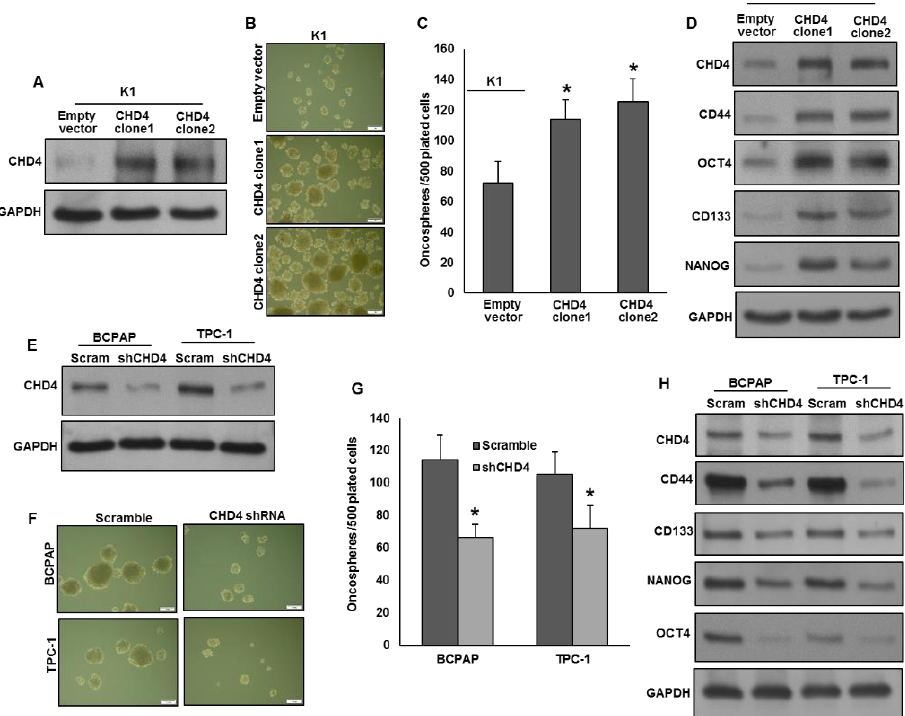
Figure 3. CHD4 promotes the self-renewal ability of spheroids generated from PTC cells. ( A ) Forced expression of CHD4 in low expressing cells. ( B , C ) Forced expression of CHD4 increases spheroid growth. K1 cells were transfected with either empty vector or CHD4 cDNA and cells were subjected to sphere forming assay. Spheroids in the entire dish were counted. (Scale bars, 1 mm). ( D ) Forced expression of CHD4 increases stemness of spheroids as confirmed by immunoblotting using stem cell markers. K1 cells were transfected with either empty vector or CHD4 cDNA and grown in sphere medium. Proteins were isolated from spheroids and immunoblotted with antibodies against CHD4, CD44, OCT4, CD133, NANOG and GAPDH. ( E ) Knockdown of CHD4 in expressing cells. PTC cells were transfected with CHD4 shRNA and knockdown was confirmed by immunoblotting. ( F , G ) Silencing of CHD4 attenuates self-renewal ability of spheroids. PTC cells were transfected with CHD4 shRNA and cells were subjected to sphere forming assay. Spheroids in the entire well were counted. (Scale bars, 1 mm). ( H ) Silencing of CHD4 reduces stemness of spheroids. PTC cells were transfected with CHD4 shRNA and grown in sphere medium. Proteins were isolated from spheroids and immunoblotted with antibodies against CHD4, CD44, OCT4, CD133, NANOG and GAPDH. Data presented in the bar graphs are the mean ± SD of two independent experiments. * Indicates a statistically significant difference compared to control with p < 0.05.